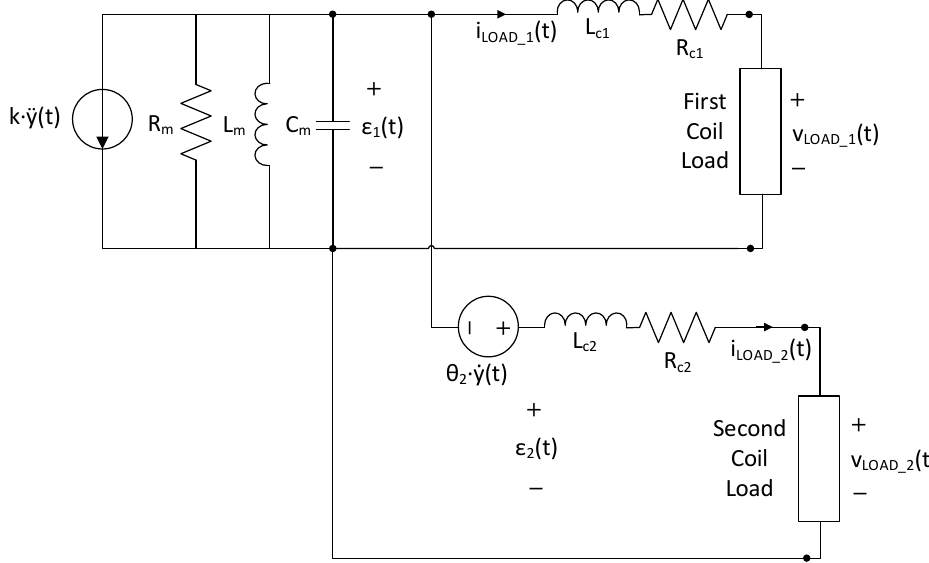
Figure 5. Equivalent circuit of a double coil resonant electromagnetic vibration energy harvester whose second additional coil has the same parameters of the first coil ( R c 2 = R c 1 , L c 2 = L c 1 and θ 2 = θ 1 = θ